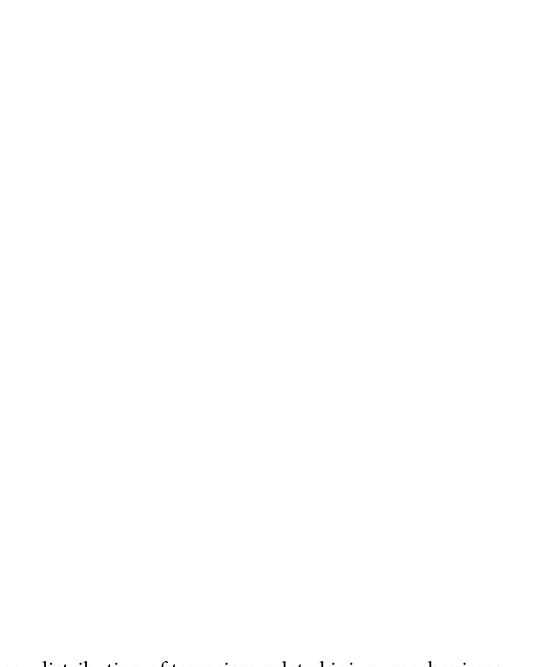
Table 1. Circumstantial characteristics, age, and sex distribution of terrorism-related injury mechanisms. *Number of injured patients/number of attacks. **In Somali, the weekend is on Thursday and Friday.